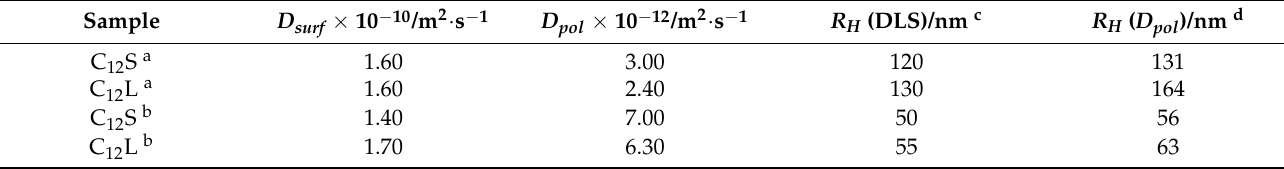
Table 4. Self-diffusion coefficients for surfactant ions (D surf ) and polyions (D pol ) in dispersions at 25 mM of charge concentration: comparing dispersions prepared by the complex salt approach to those prepared by a conventional protocol. The table also includes hydrodynamic radii (R H ) obtained from dynamic light scattering (DLS) and from the polyion self-diffusion coefficients using the Stokes–Einstein relation. Self-diffusion measurements performed in a 400 MHz Bruker Avance